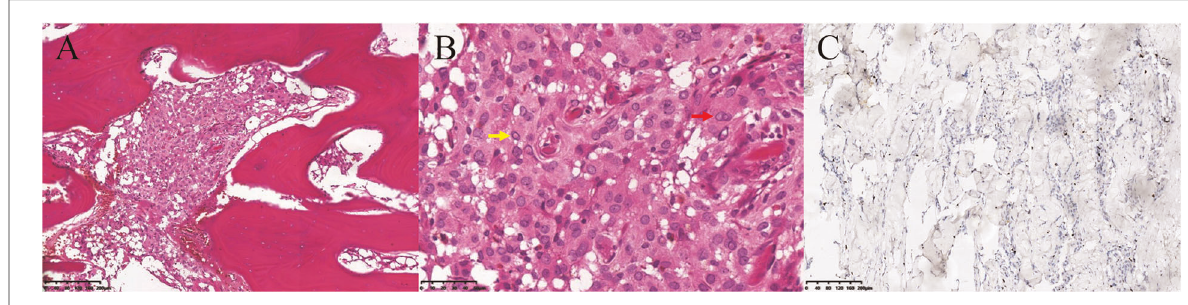
FIGURE 3 Pathology of the primary intraosseous meningioma. ( A ) The intertrabecular spaces had been in fi ltrated by meningioma cells (hematoxylin & eosin staining, 100×). ( B ) The cells had differentiated from meningothelial cells as syncytia (red arrow), with some intranuclear inclusions (yellow arrow) and exhibited a low Ki-67 proliferation rate ( C